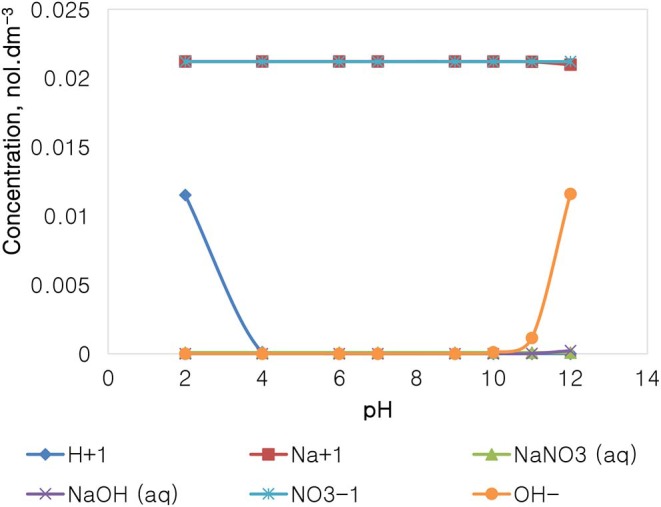
NaNO3 speciation for a solution of 0.0213 mol dm−3 ionic strength.